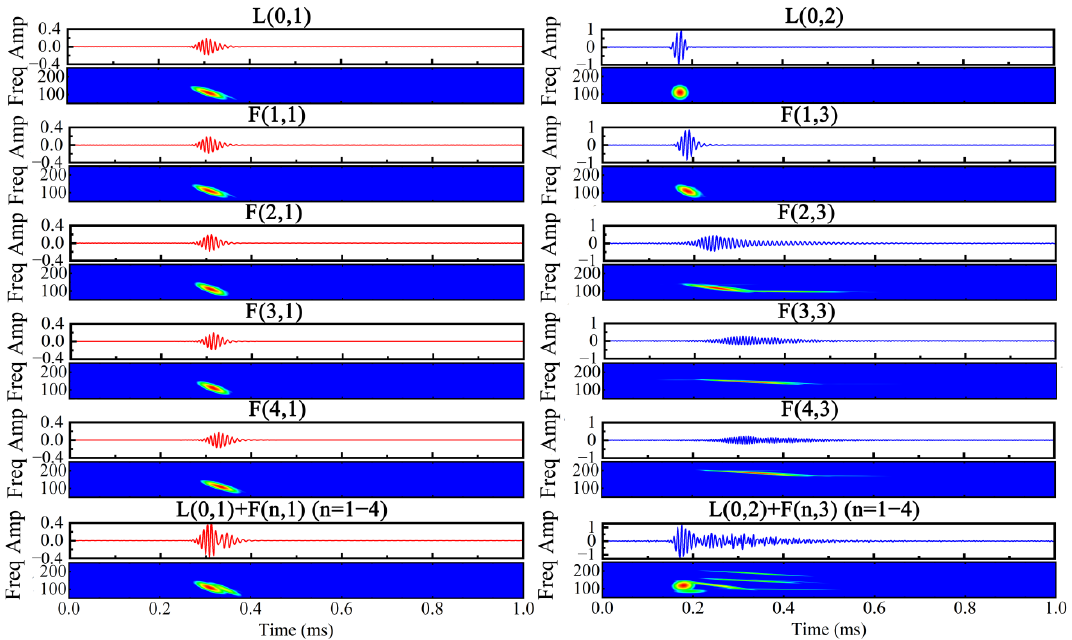
Figure 5. Time–frequency diagrams of L(0,1), F( n ,1), L(0,2) and F( n ,3) UGW synthesized signals (1 ≤ n ≤ 4) propagating 0.8 m.